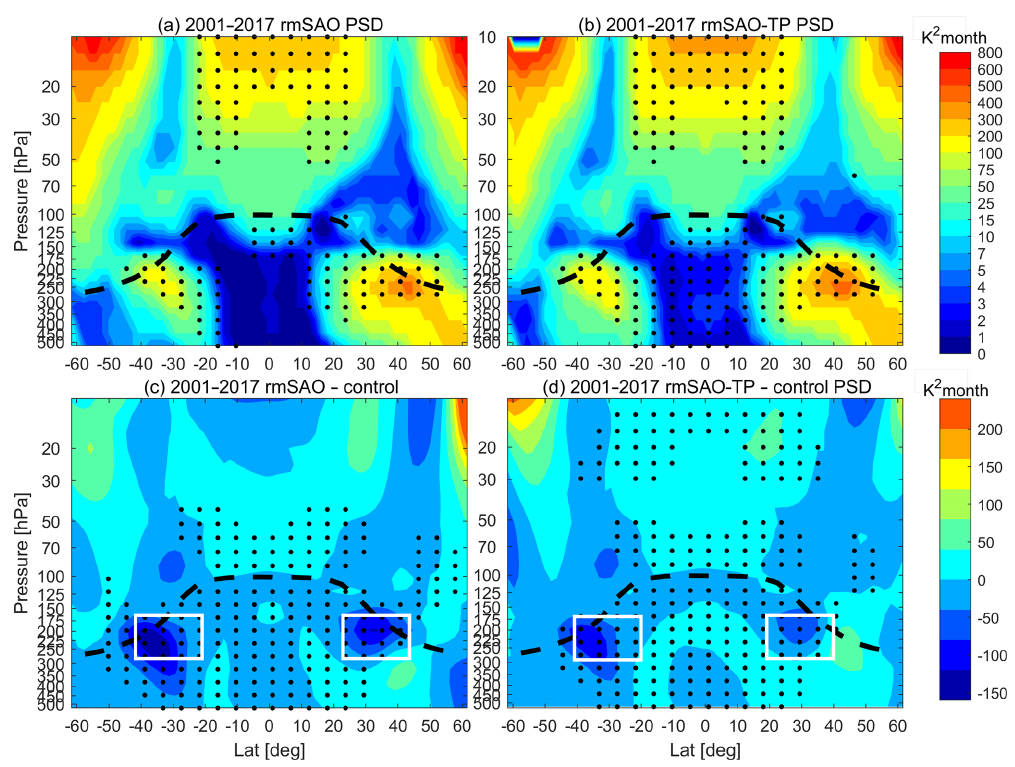
Figure 7. (a) The PSD of SAO analyzed for the period 2001–2017 based on model simulation with removed SST-SAO (rmSAO). (b) Same as (a) , but for the simulation with removed SST-SAO in the Tropics (rmSAO-TP). The dots mark the significant area at 95% level. (c) The difference of SAO PSD between the rmSAO and the control simulations (rmSAO – Control) for the period 2001–2017. (d) Same as (c) , but for the difference between the rmSAO-TP and the control simulations (rmSAO-TP – Control). The black dots mark areas with significant differences of the two time series at 95% level based on t-test. The dashed black lines mark the tropopause height calculated with GNSS RO